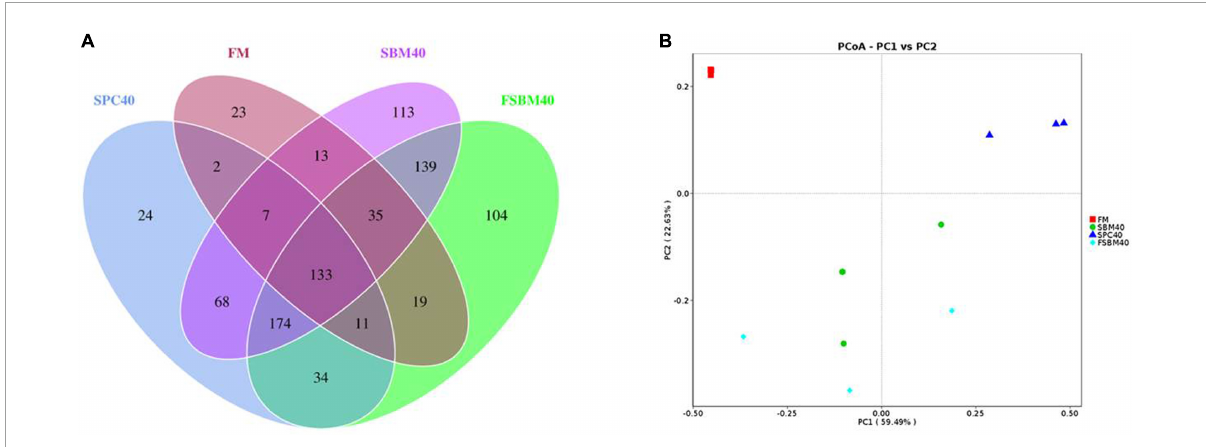
FIGURE2 Venn plot (A) and PCoA (B) analysis of OTU by high-throughput sequencing after replacing fish meal with different soy meals in pearl gentian grouper ( n = 3).